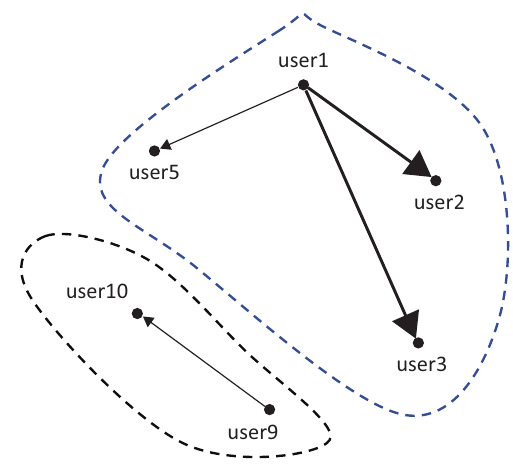
Figure 1. Support for and institutionalization of direct democracy. Source: Geissel